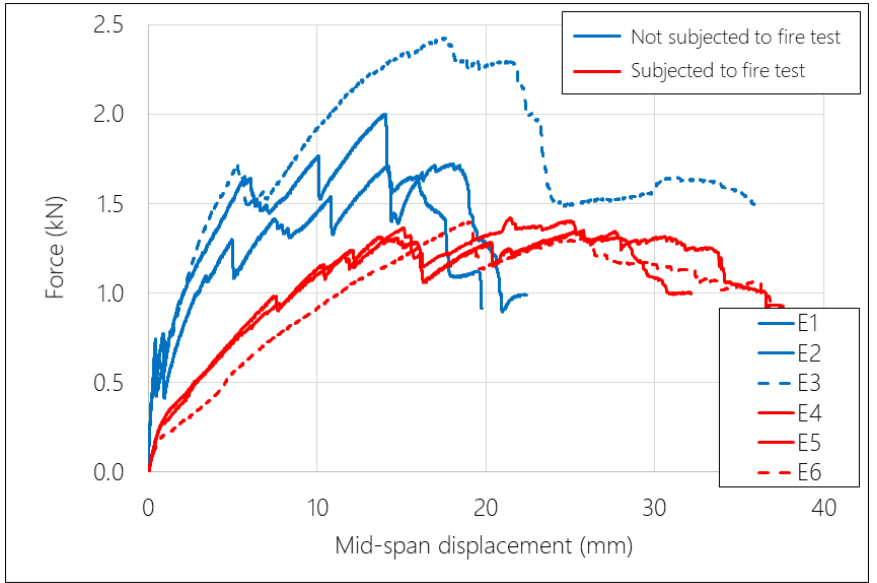
Figure 9. Force versus displacement curves for specimens in Series E.